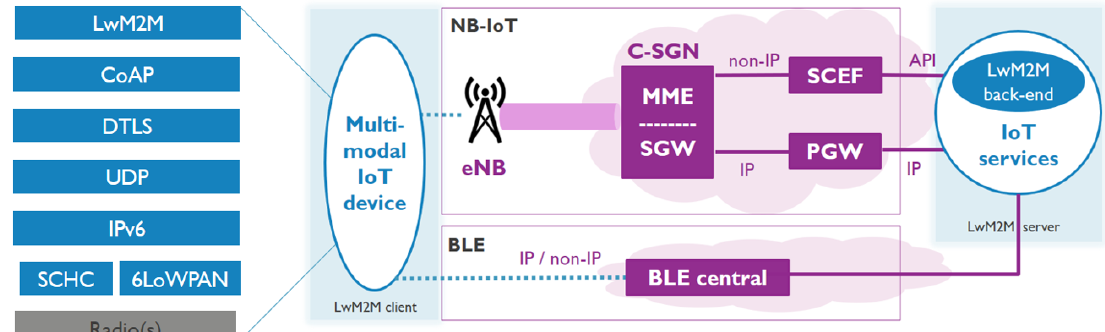
Figure 1. Envisioned multimodal communication architecture, leveraging on standardized IoT protocols and able to deal with the specific wireless communication